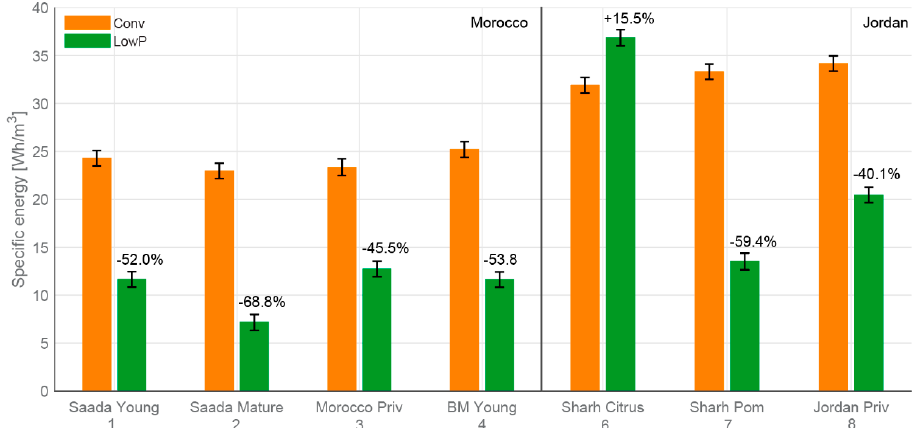
Figure 7. Specific hydraulic energy (total hydraulic energy per total volume of water delivered) at